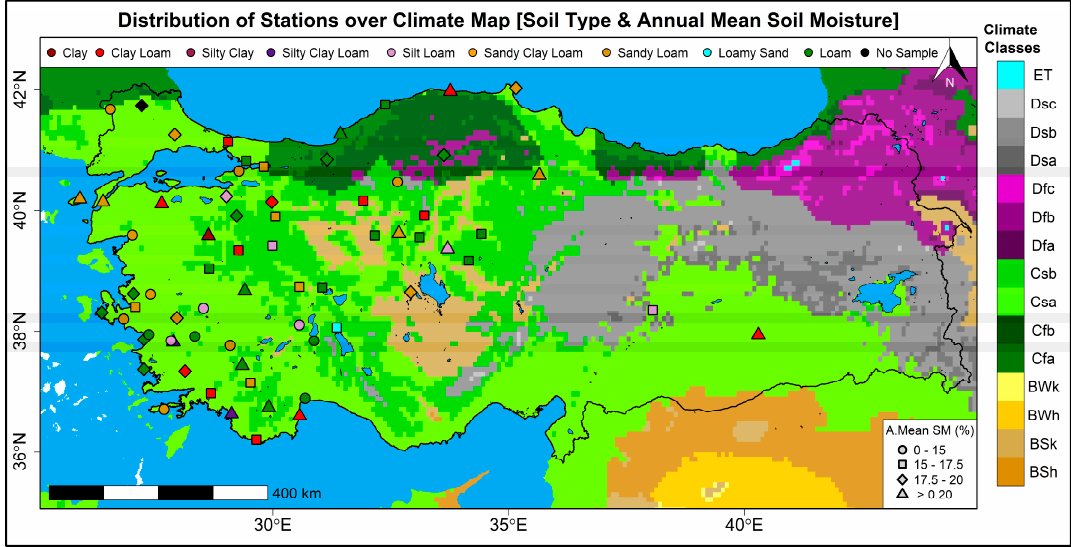
Figure 7. Distribution of stations with classifications over Climate Class Map.